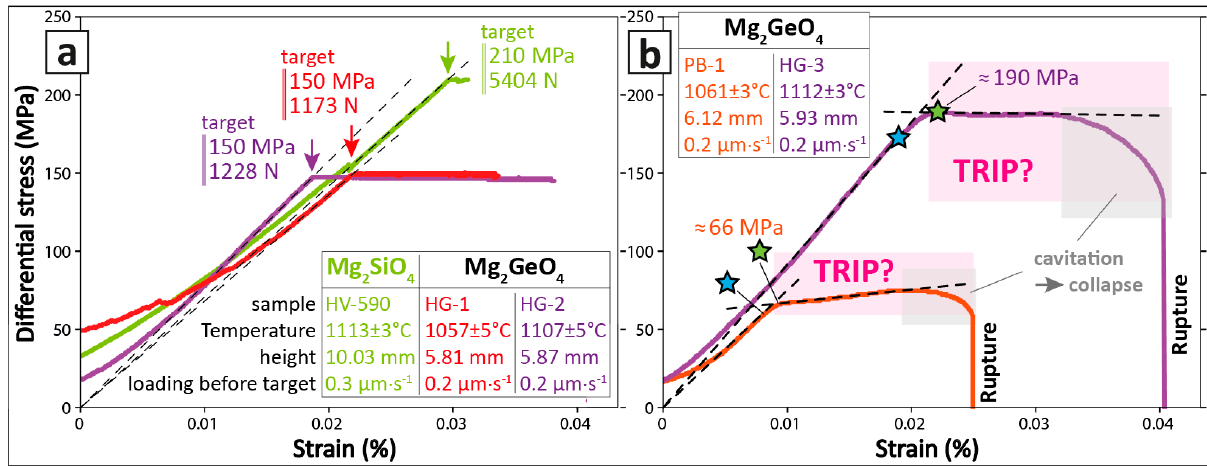
Figure 12. Additional experiments on Mg 2 SiO 4 (+MgSiO 3 ) and Mg 2 GeO 4 (+MgGeO 3 ) samples from other studies. ( a ) Experiments that do not exhibit enhanced plasticity; ( b ) Enhanced plasticity (load target never reached) reproduced in germanate samples synthetized for previous studies, which we propose to interpret as TRIP. All samples contain minor enstatite (Table 1). Samples ‘HV’, ‘HG’ and ‘PB’ are respectively described by [125,131,132]. See the signification of the blue and green stars in Figure 6.